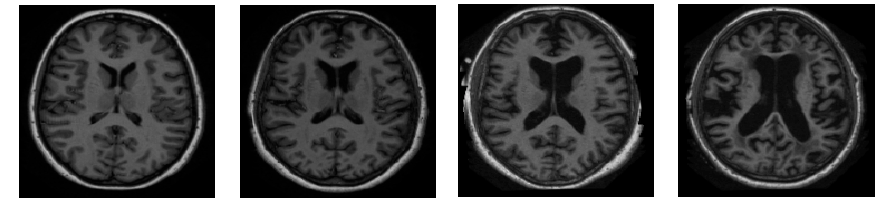
Figure 4. Sample images from